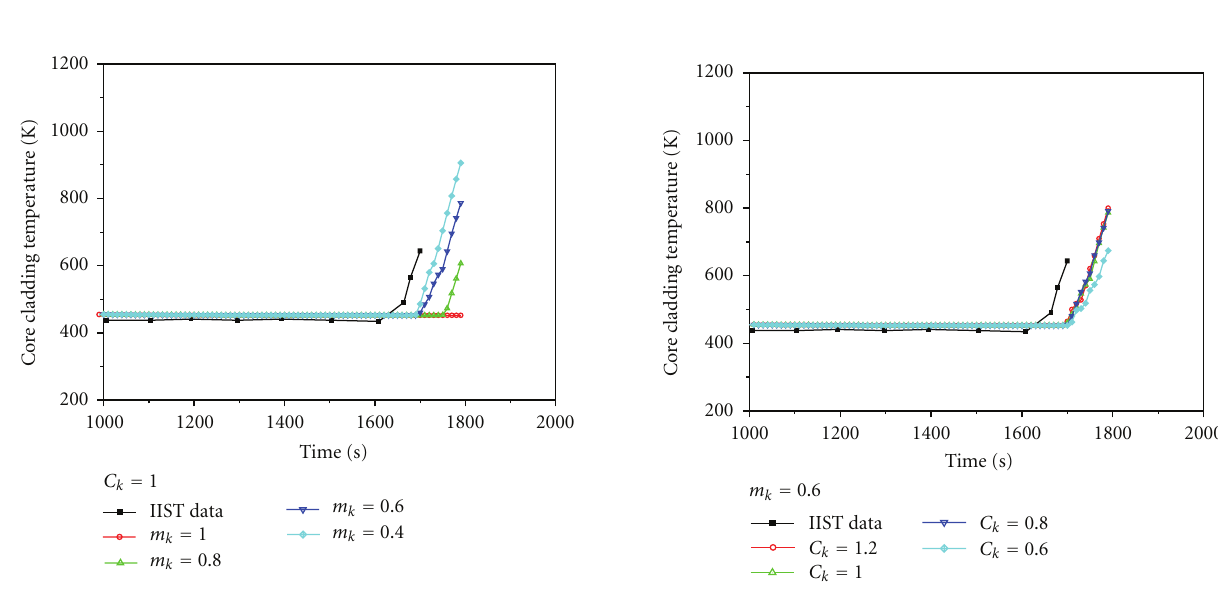
Figure 13: The CCFL sensitivity study of C k for core cladding